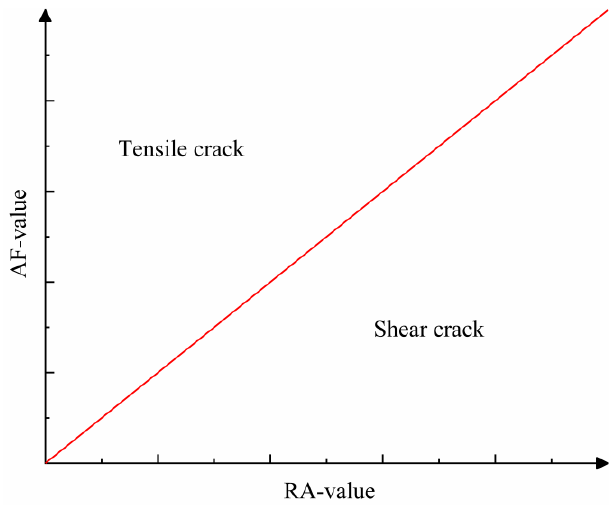
Figure 9. Relationship between crack types and RA – AF distribution.